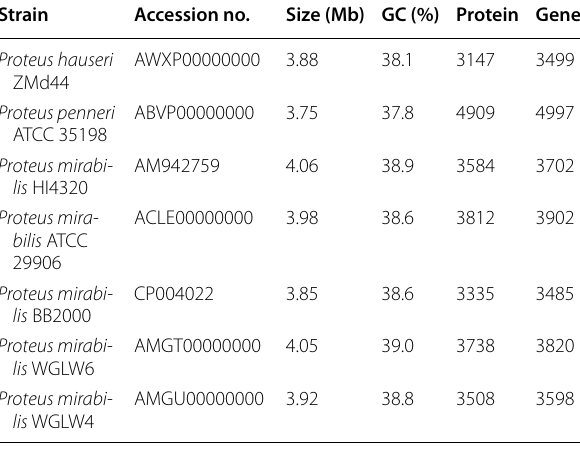
Table 1 Comparative list of Proteus strains with